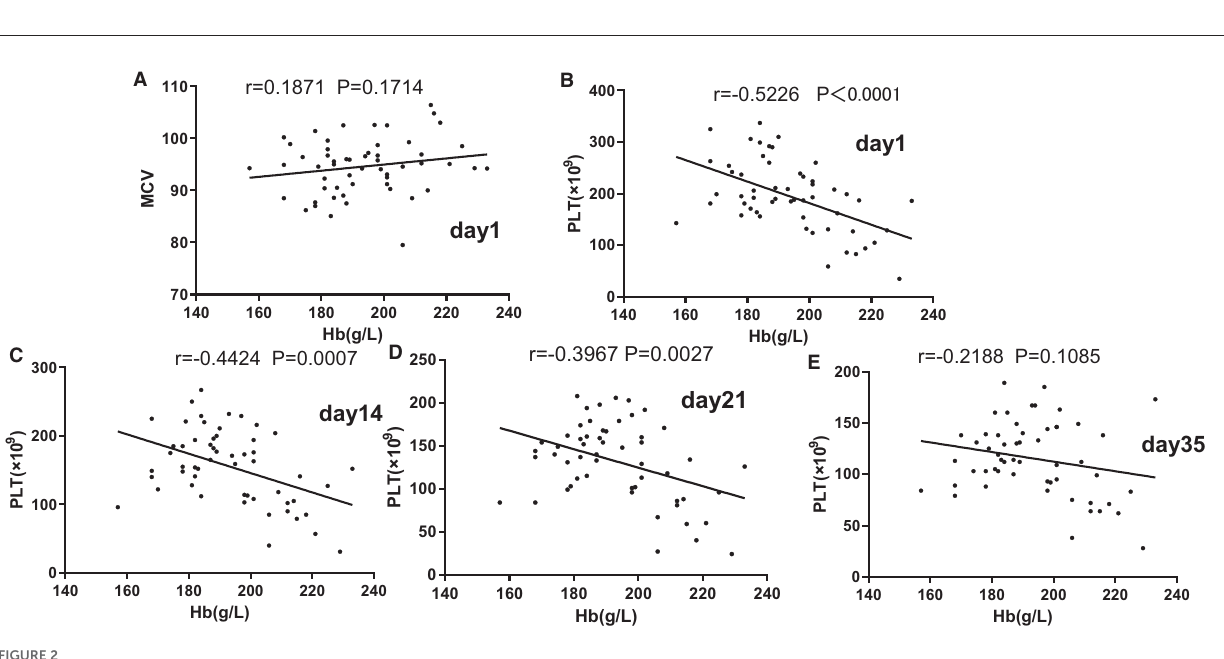
The results (Table 1) revealed that group C had higher change rates of all these parameters than group A and that group B had